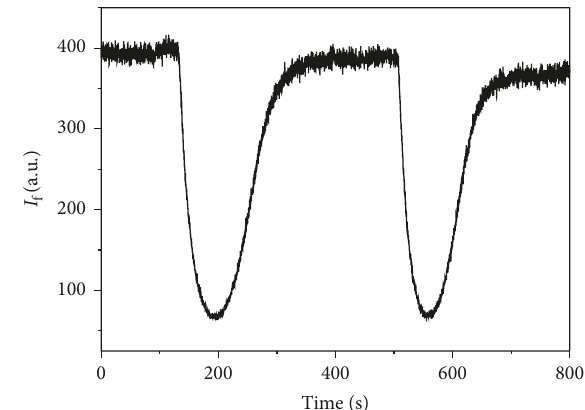
5 M BZF methanolic 10 × −